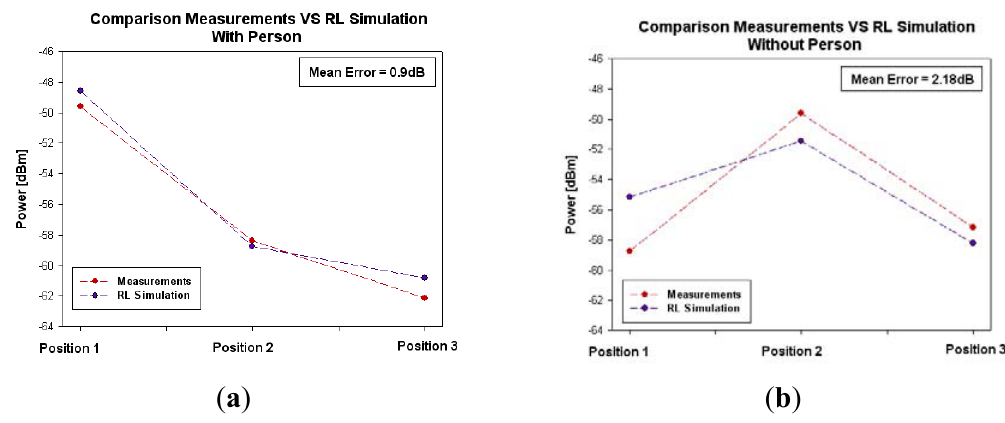
Figure 12. Comparison simulation versus measurements for different positions of the receiver in the considered scenario ( a ) With person ( b ) Without person.